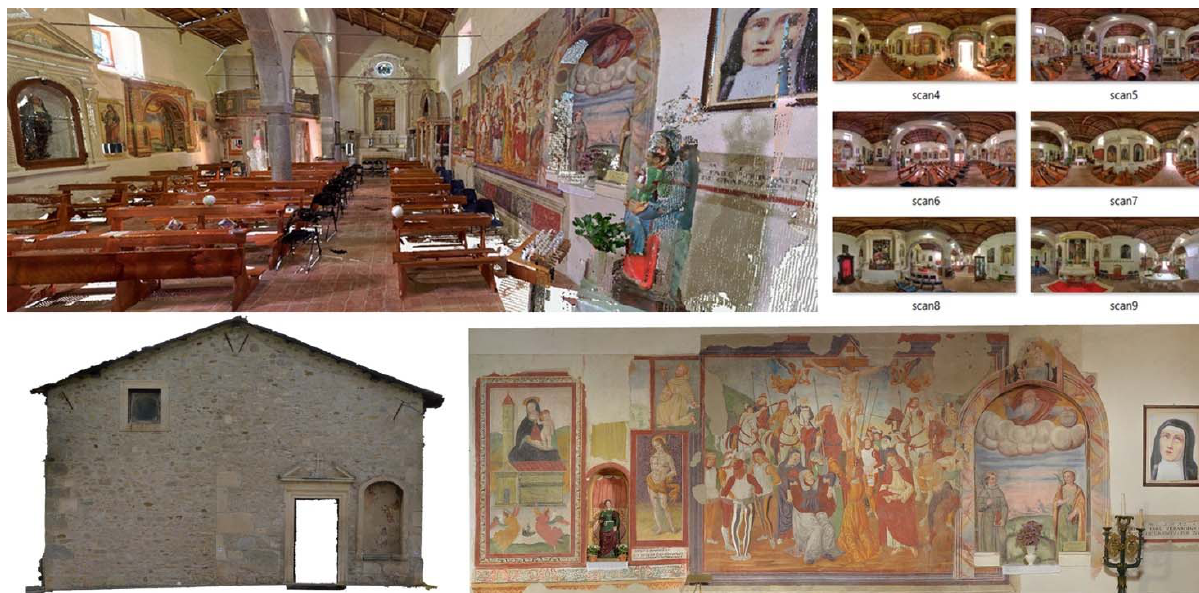
Figure 3. Point clouds and equirectangular images, top; orthophotoplans extrapolated from the textured photogrammetric model,